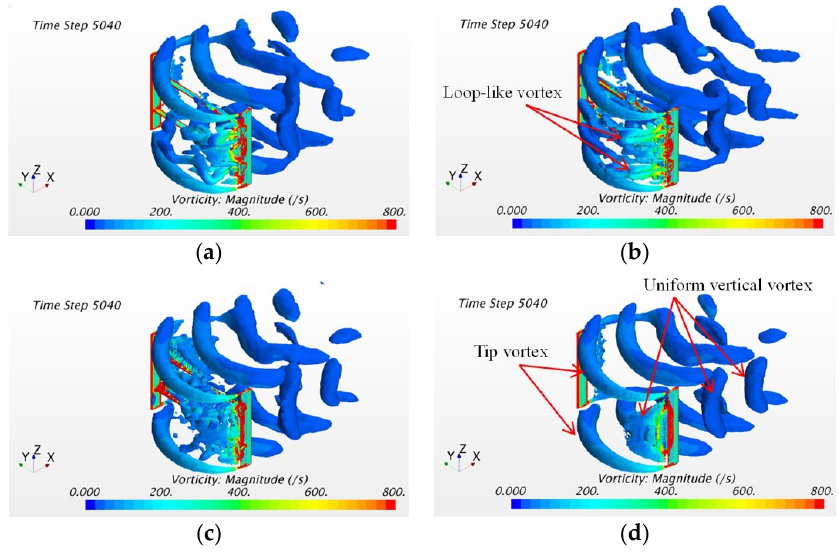
Figure 6. Q -criterion (second invariant of velocity gradient) isosurfaces (200 s − 2 ) and the vorticity distribution on those surfaces: ( a ) airfoil arm rotor, ( b ) rectangular arm rotor, ( c ) circular arm rotor, and ( d ) armless rotor.